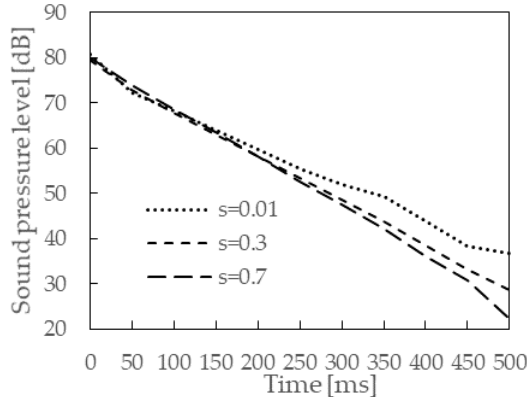
Figure 3. Decay curves related to the rectangular space under surface scattering coefficients of different values